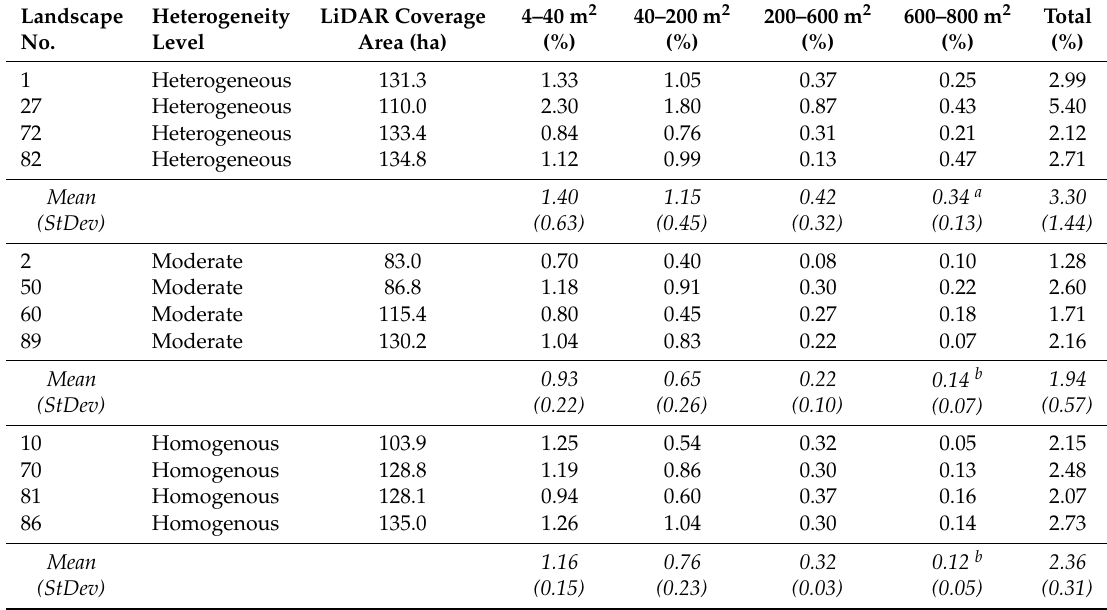
Table 2. Proportion of landscape in gaps of di ff erent size classes. Means with di ff erent letters (column-wise) are significantly di ff